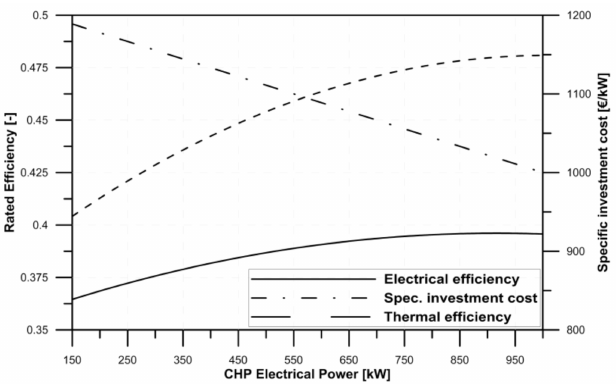
Figure 5. Variation in the nominal efficiencies and specific investment cost with the cogeneration plant